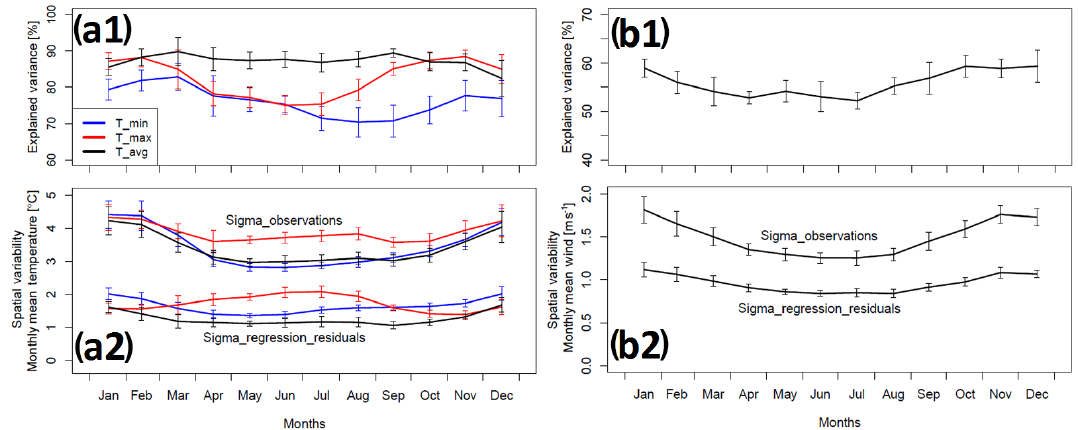
Figure 15. Annual cycles (means 2001–2010) of relative explained variance for monthly mean temperature ( a1 , see color code of the parameters) and wind speed (b1) and corresponding spatial variability (1 σ ) before and after regression (a2, b2) . All data are given as means over all regions. The error bars display the temporal standard deviation over the 10